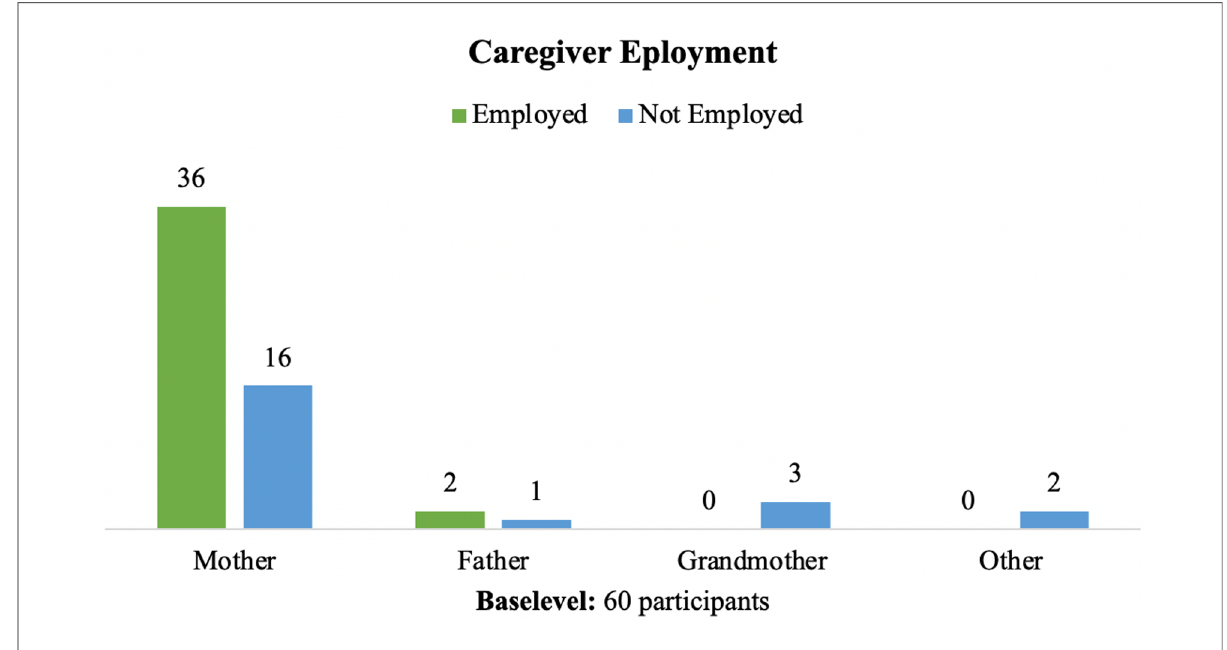
FIGURE 4 Caregiver work activity at the onset of COVID-19